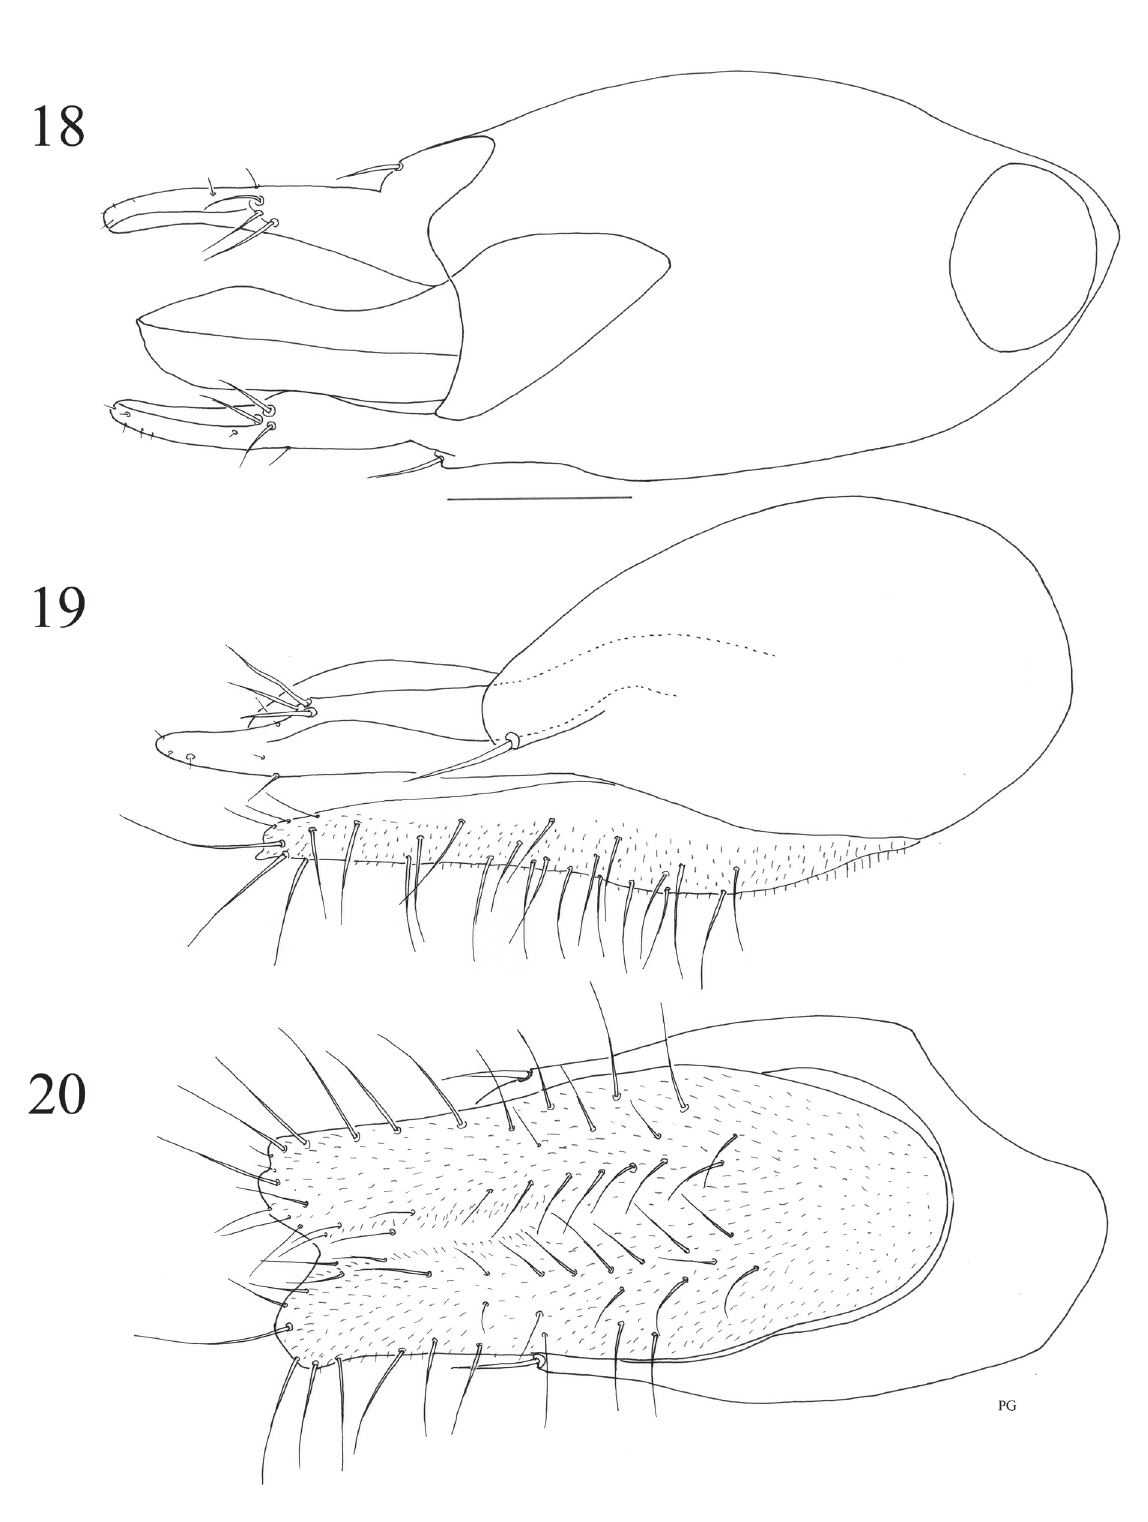
Figs 18–20. Thinophilus parmatoides sp. nov., ♂, terminalia. 18 . Genital capsule, ventral view. 19 . Genital capsule, lateral view. 20 . Cerci, dorsal